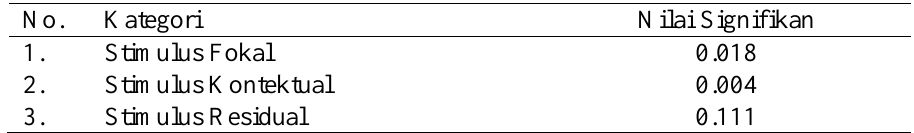
Tabel 5. Hasil Analisa Data : uji statistik regresi logistik faktor stimulus dengan mekanisme koping